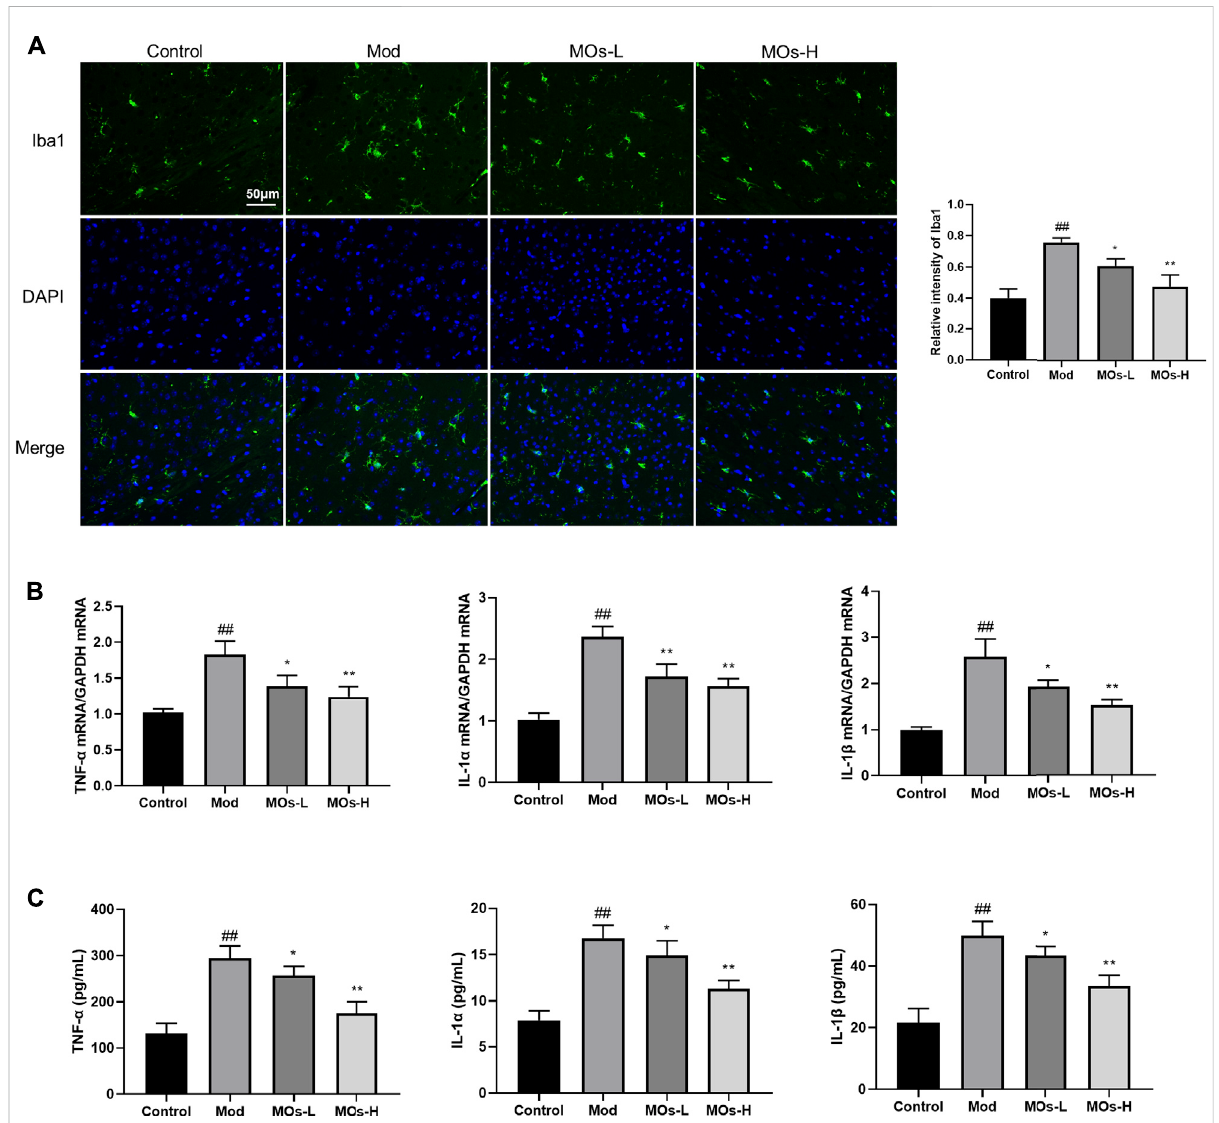
FIGURE 3 MOs protect from CMS-induced in fl ammation. (A) Representative hippocampus immuno fl uorescent staining for Iba1 (green) and nuclei (blue), and quanti fi cation of relative intensity of Iba1 ( n = 3). (B) Measurement of TNF- α , IL-1 α and IL-1 β mRNA levels in the hippocampus ( n = 3). (C) TNF- α , IL-1 α and IL-1 β concentrations in the serum ( n = 6). Data are expressed as means ± SD. ## p < 0.01 vs. control; * p < 0.05; ** p < 0.01 vs.